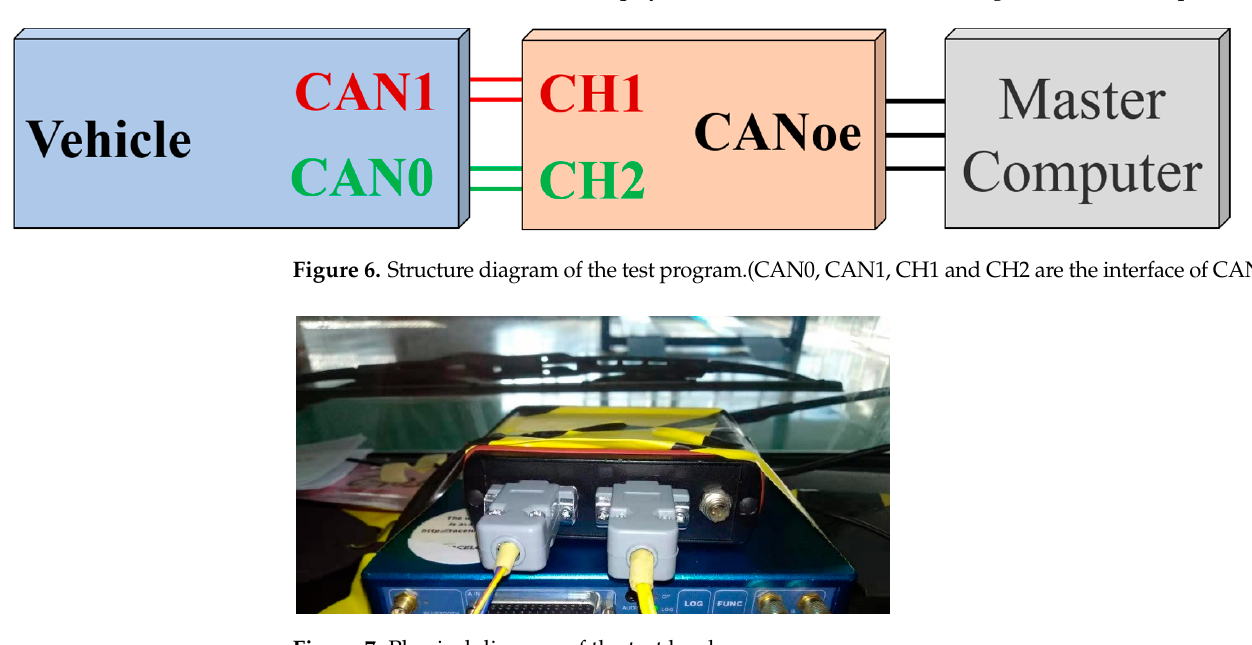
Figure 7. Physical diagram of the test hardware.